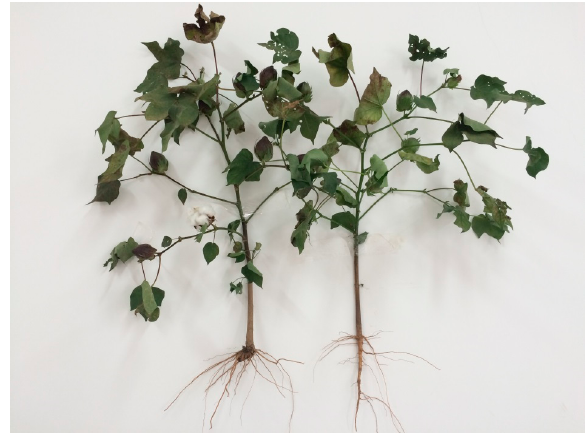
Figure 1. Root morphologies resulting from different planting patterns (transplanted cotton on the left , direct-seeded cotton on the right ).